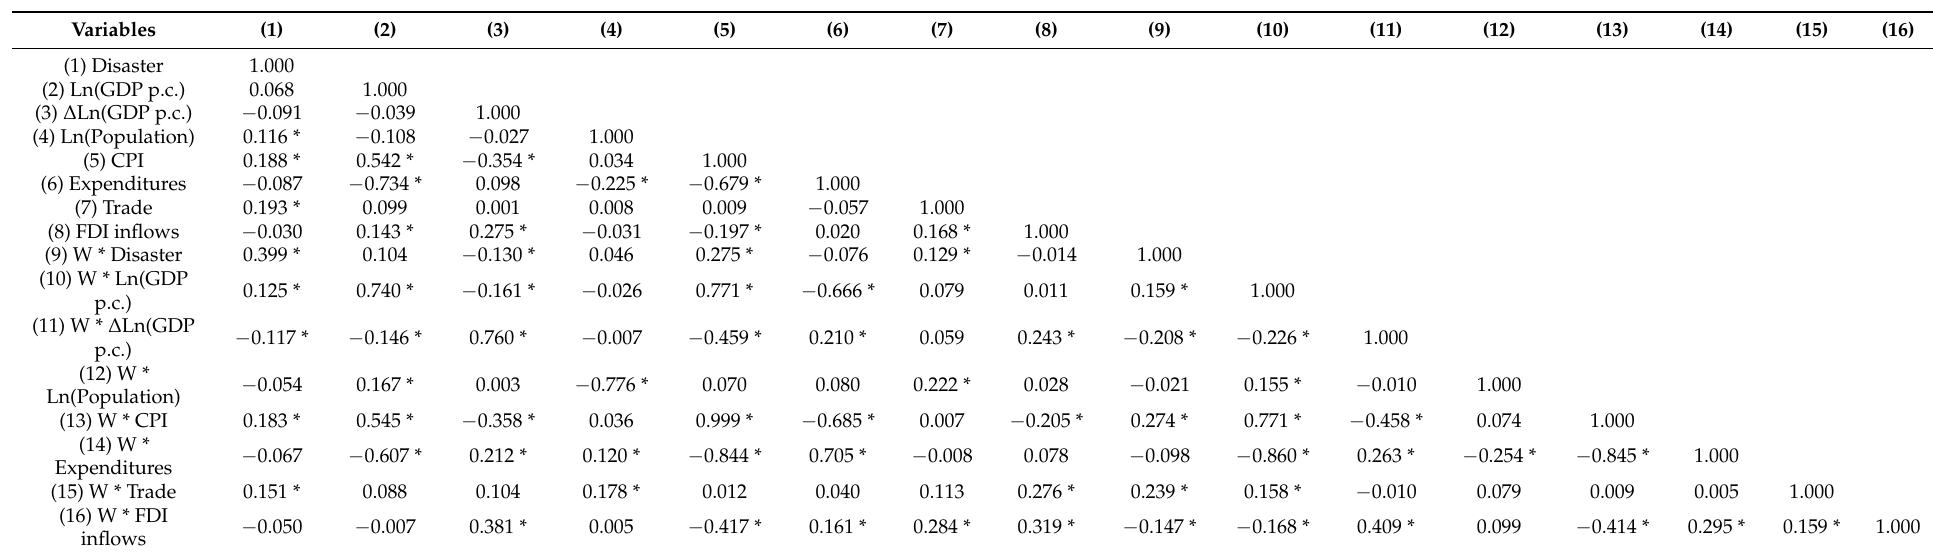
Table A5. Correlation matrix of used variables (including spatial